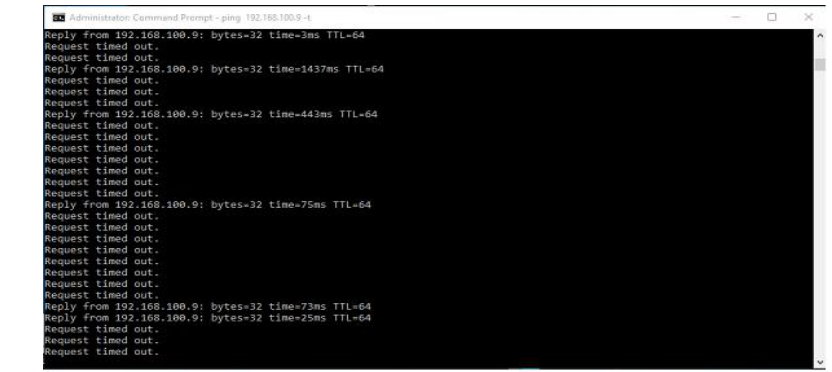
Figure 6 – Checking the availability of the targeted computer after the attack using